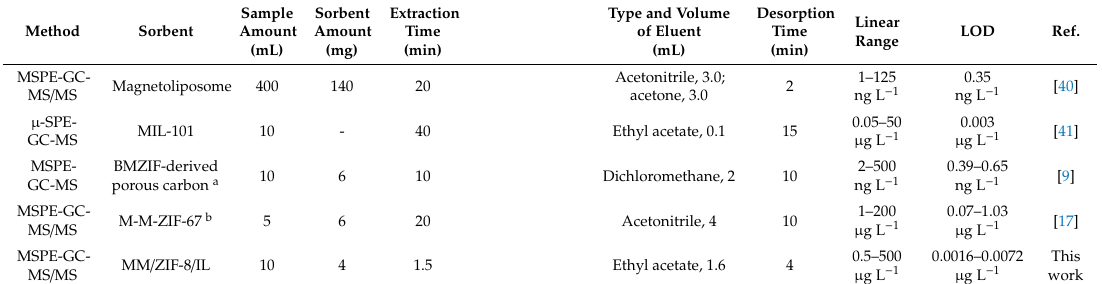
Table 2. Comparison of di ff erent methods for analysis of DDTs in water